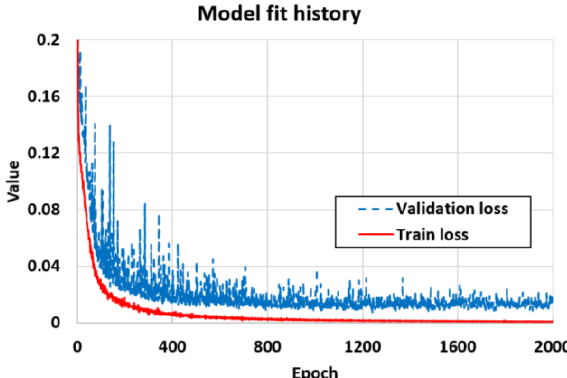
Figure 6. Training and validation losses according to epochs.